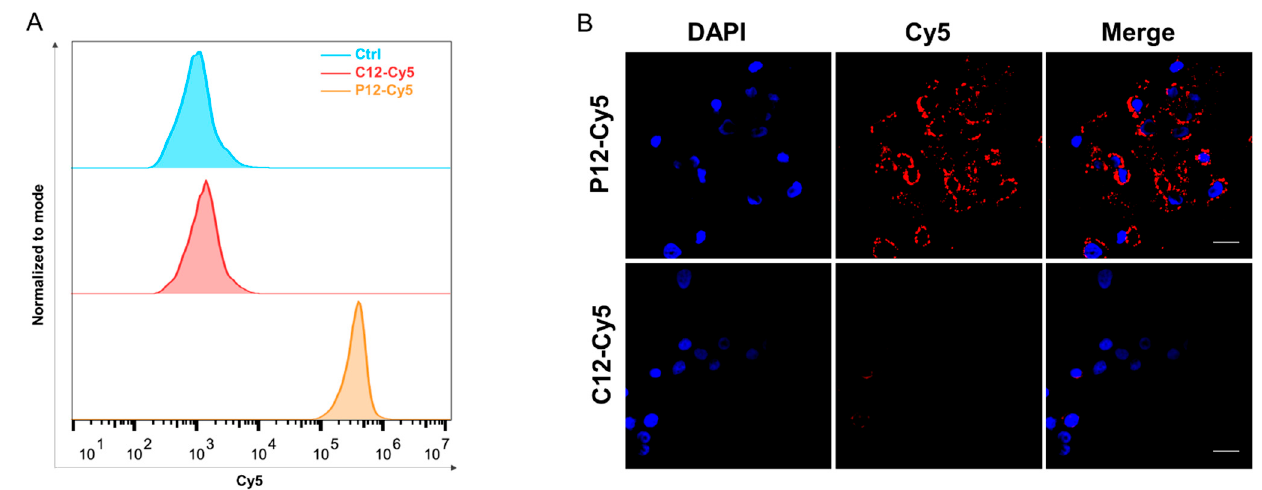
Figure 4. Binding of IGF2BP2-targeted peptide to cancer cell lines. ( A ) Flow cytometric analysis of KYSE-30 cells after treatment with C12-Cy5 or P12-Cy5 peptide. ( B ) Confocal images of KYSE-30 cells after incubation with C12-Cy5 or P12-Cy5 peptide. Scale bar: 20 μ m.